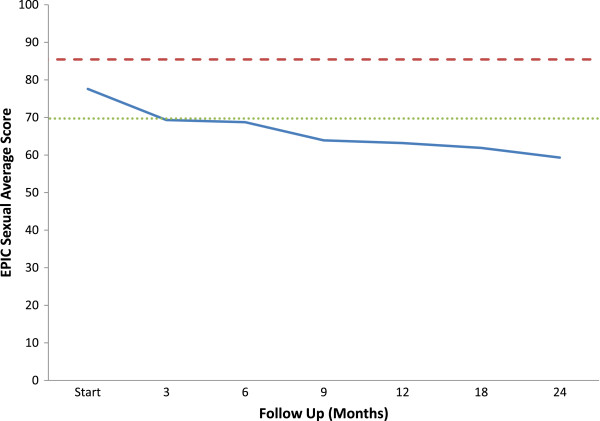
Average EPIC sexual domain scores at baseline and following SBRT for prostate cancer. Thresholds for clinically significant changes in scores (½ standard deviation above and below the baseline) are marked with dashed lines. EPIC scores range from 0–100 with higher values representing a more favorable health-related QOL.